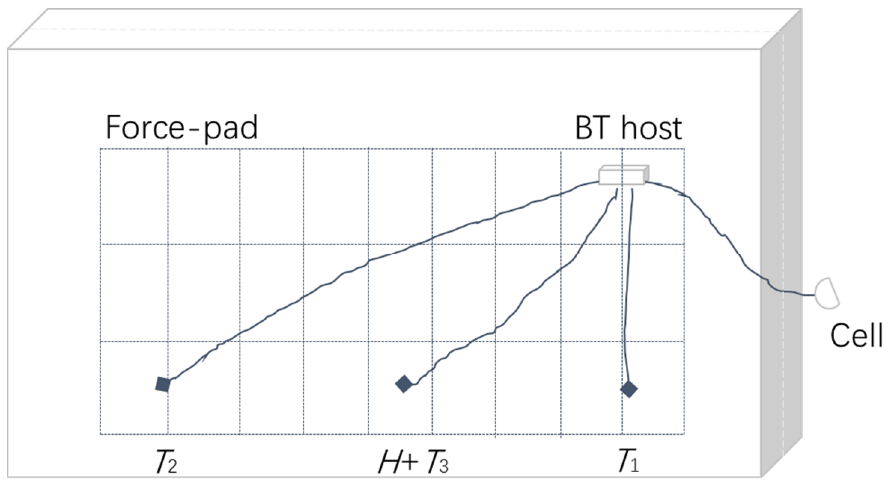
Figure 3. The diagram of the “Smart Magic Pillow”.